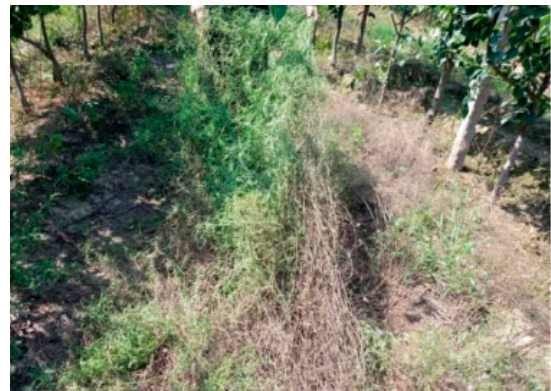
Figure 1. The entanglement between hairy vetches.